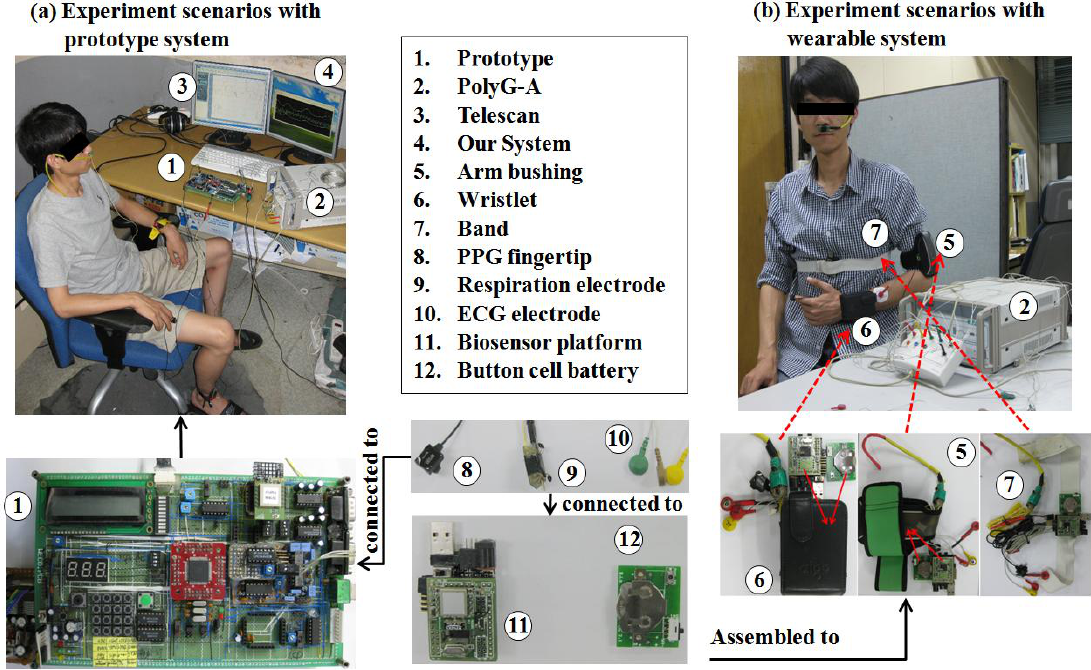
Figure 10. ( a ) The experimental scenarios with prototype system (desktop); ( b ) the experiment scenarios with wearable biofeedback